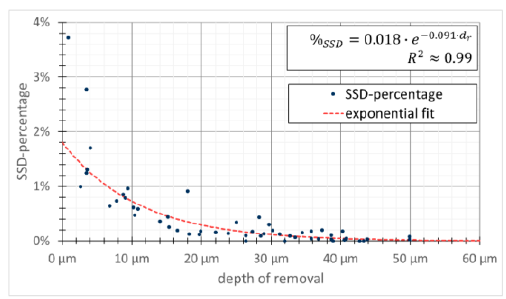
Fig. 3. LSM mapping of an unetched surface.